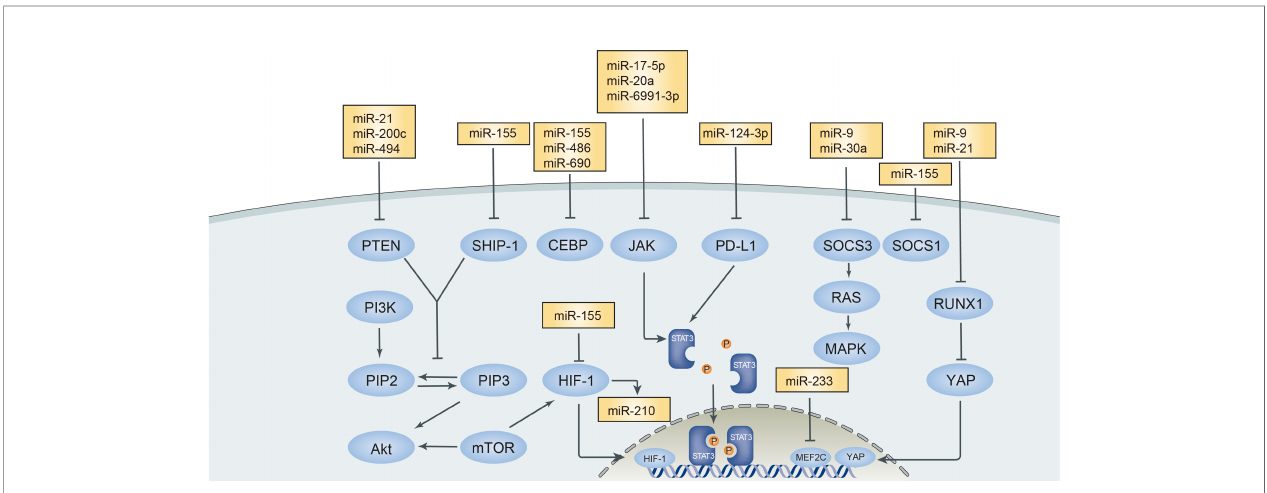
FIGURE 1 | Main signal pathways interacted with microRNAs in tumor microenvironment. MicroRNAs in tumor microenvironment exert positive or negative effect on MDSCs targeting different signal pathways. PTEN, Phosphatase and tensin homolog; SHIP-1, Src Homology 2-containing inositol phosphatase-1; CEBP, CCAAT/ enhancer binding protein; JAK-STAT3, Janus kinase-signal transducer and activator of transcription; PD-L1, Programmed death-ligand 1; SOCS3, suppressor cytokine signaling 3; RUNX1, runt-related transcription factor 1; MEF2C, MADS box transcription enhancer factor 2, polypeptide